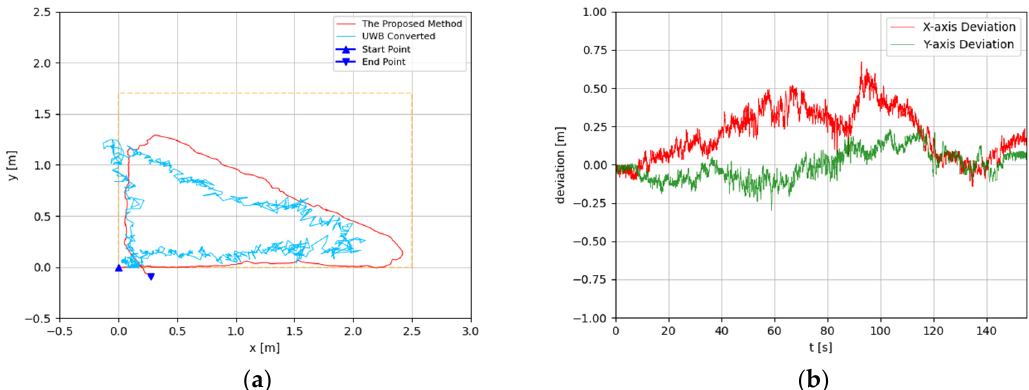
Figure 12. ( a ) Trajectory of right-triangle-shaped path in the first test; ( b ) Positioning comparison of right-triangle-shaped path in the first test.